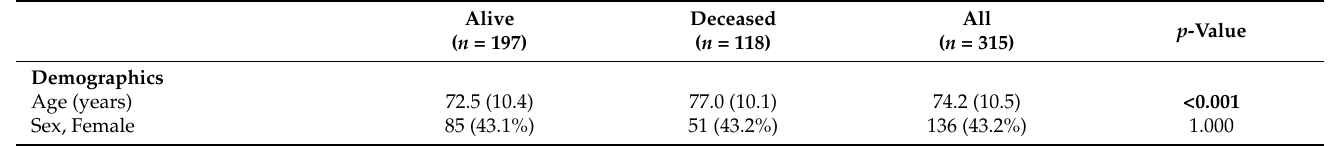
Table 1. Baseline characteristics and laboratory data of AHF patients upon hospital